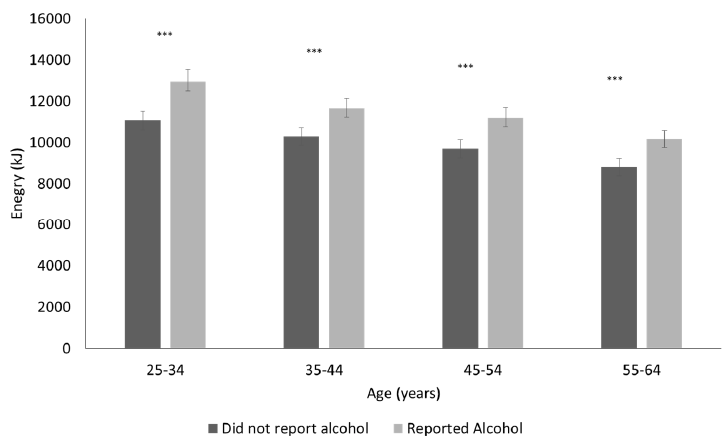
Figure 3. Mean (95% Confidence Intervals) energy for men reporting alcohol intake compared to those not reporting alcohol on the day of the survey from the three national nutrition surveys (1983, 1995, and 2011/12). *** p < 0.001 One-way analysis of variance.